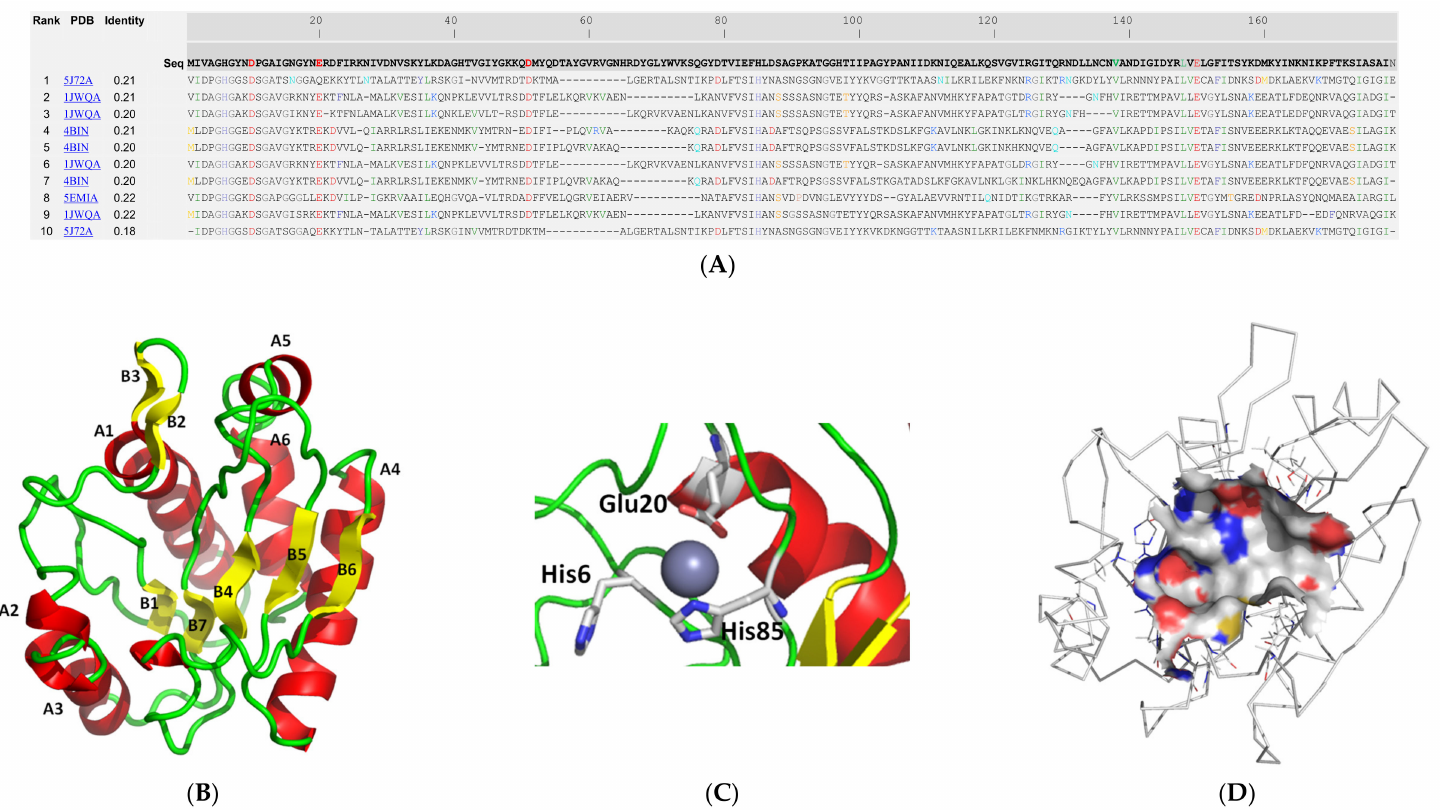
Figure 4. Structure prediction of the MurNac-LAA domain using the I-TASSER approach [28,29]. ( A ). Ten best threading templates that were used by I-TASSER. Templates were identified by LOMETS threading programs [32] from the PDB library. All the residues are colored in black; however, those residues in template which are identical to the residue in the query sequence are highlighted in color. Coloring scheme is based on the property of amino acids, where polar are brightly coloured while non-polar residues are colored in dark shade. The column ‘identity’ is the percentage sequence identity of the templates in the threading aligned region with the query sequence. The top 10 alignments reported above (in order of their ranking) are from the following threading programs: 1, MUSTER; 2, FFAS-3D; 3, SPARKS-X; 4, HHSEARCH2; 5, HHSEARCH I; 6, Ne ff -PPAS; 7, HHSEARCH; 8, pGenTHREADER; 9, PROSPECT2; 10, PRC. ( B ): Ribbon diagram of MurNac-LAA domain. α -Helices are colored red and β -strands yellow. ( C ). The predicted zinc binding residues. Zinc is shown as a sphere ( D ). Surface aria of the predicted ligand binding site. The drawings were created using